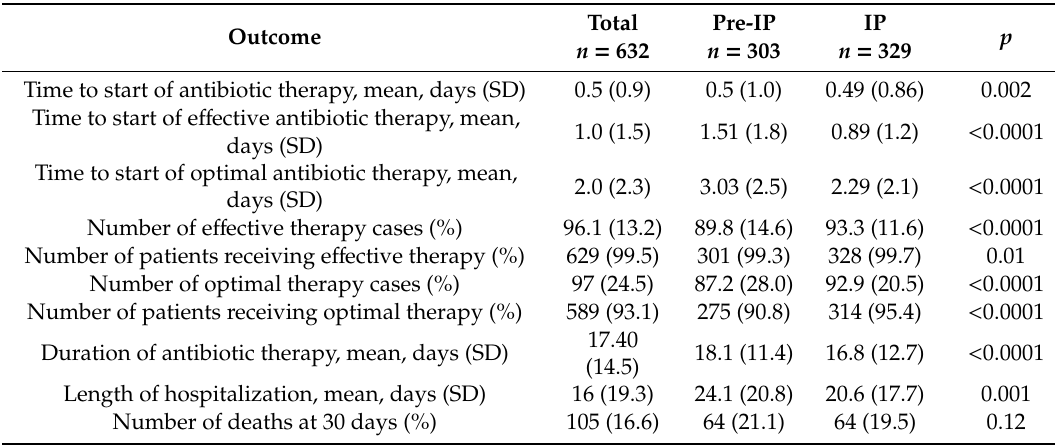
Table 4. Primary study